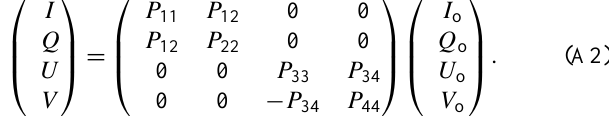
Figure A2. Linear and circular depolarisation profiles in a C1 cloud at a distance of 2km for a FOV of 1.75mrad and a wave- length of 700nm as a function of cloud optical depth (COD). The solid line shows the ECSIM results while the dashed lines shown the results calculated using an approximate analytical approach (Chaikovskaya,